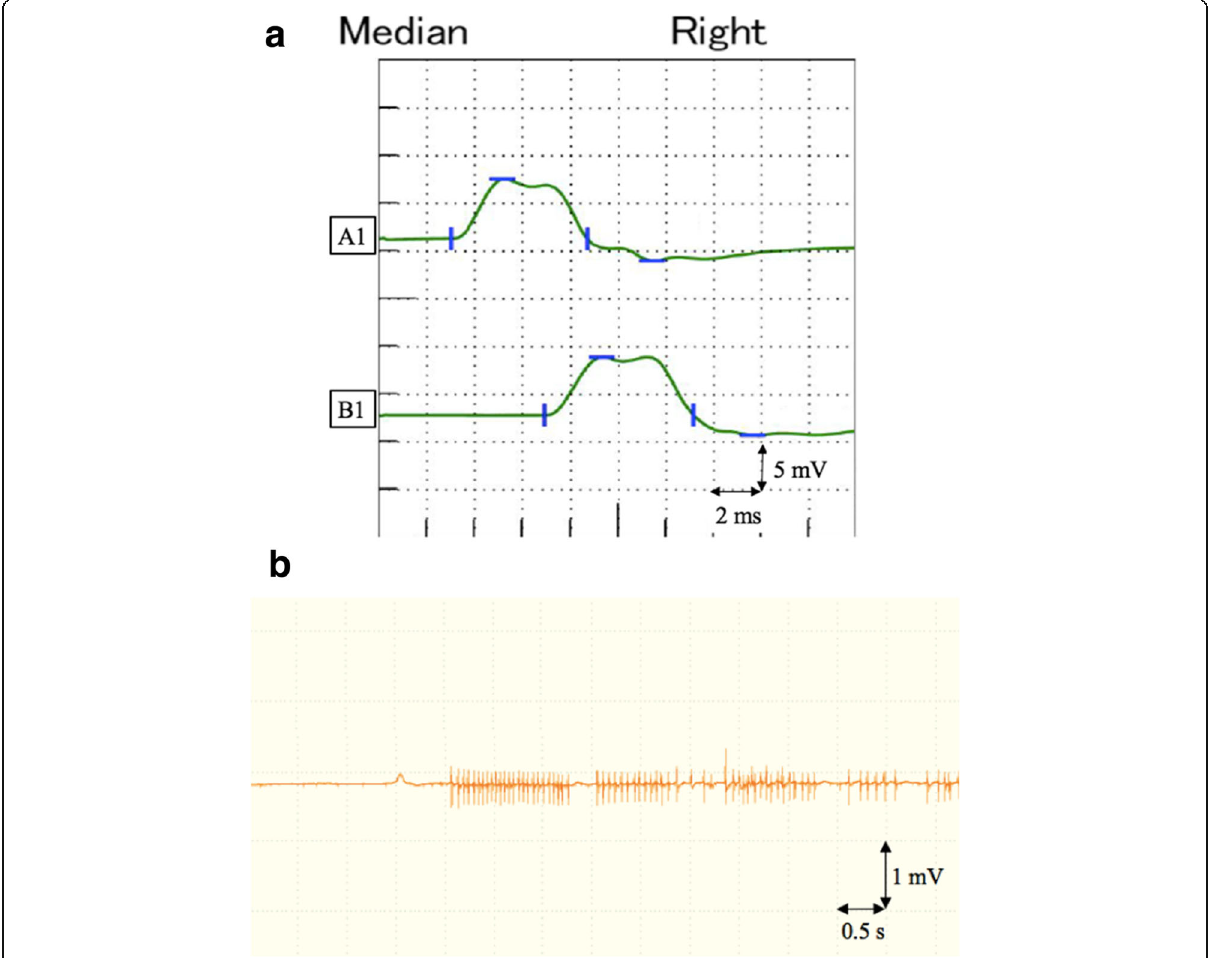
Fig. 2 a Nerve conduction studies performed 2weeks after surgery of the right median nerve with stimulations at the wrist (A1) and elbow (B1) showing reduced amplitude of compound muscle action potentials (8.5mV and 8.2mV, respectively). The latencies and nerve conduction velocities were normal. b Needle electromyography of the right biceps brachii muscle performed 3weeks after surgery showing reduced interference